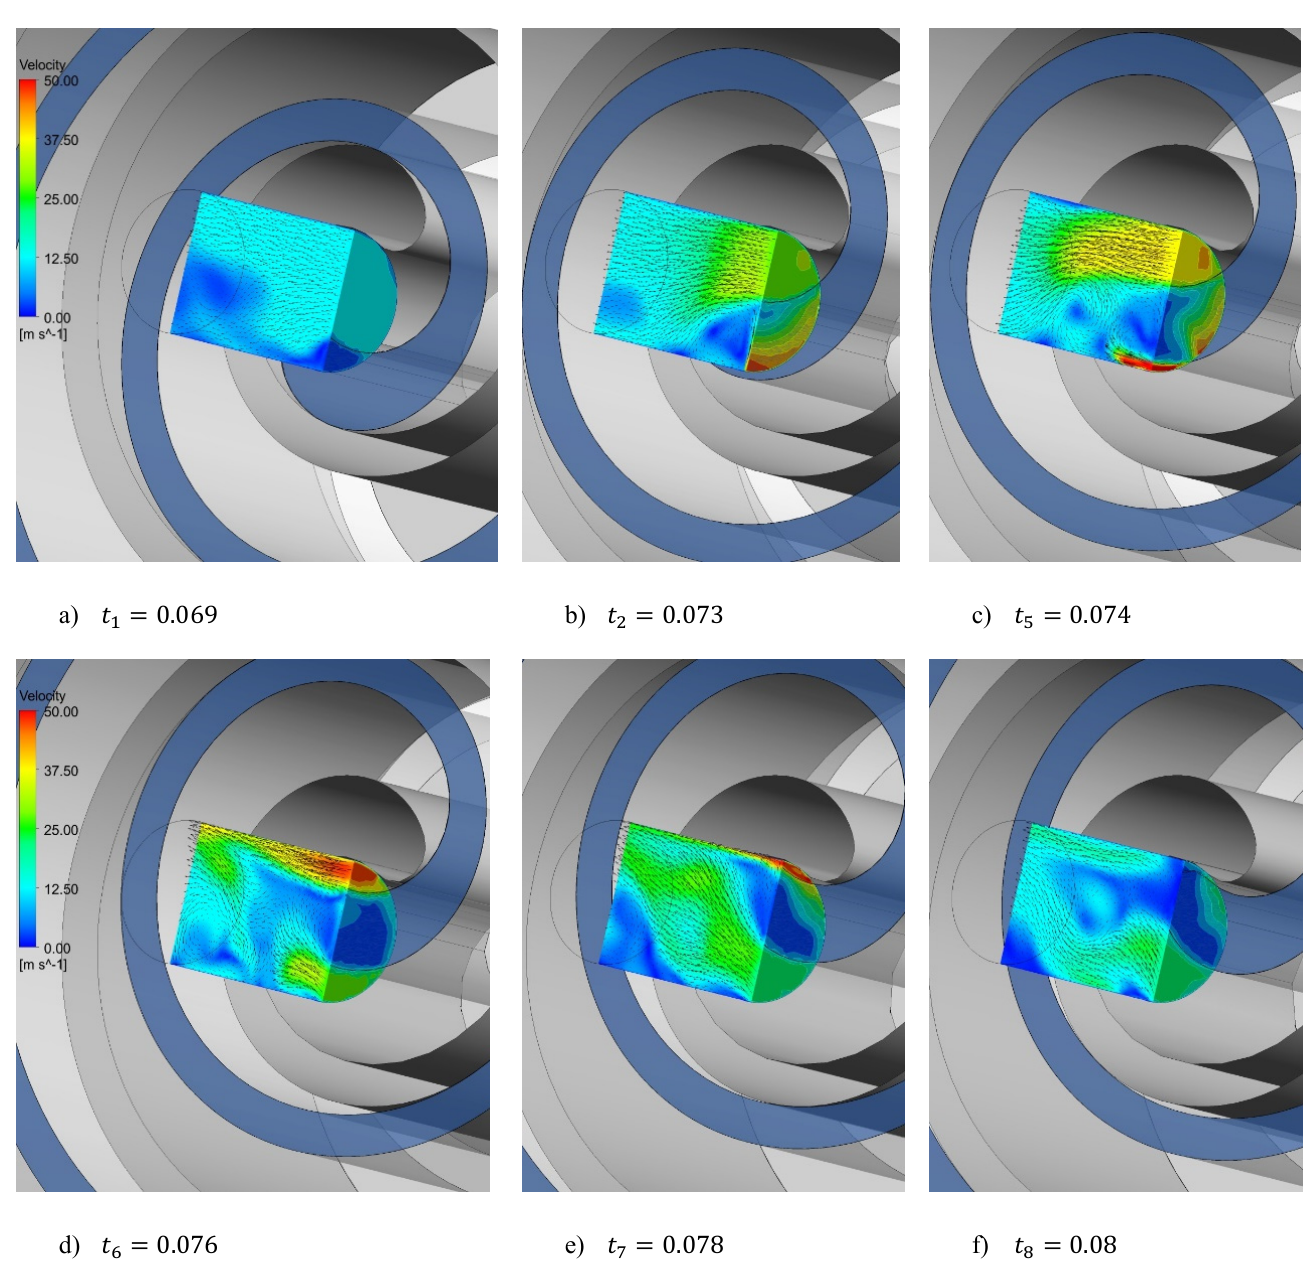
Figure 22. Vector plots of the flow field at the scroll discharge located on the discharge port (of circular shape) and an axial section plan (rectangular shape) (CFX with axial gap).